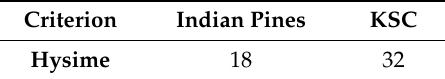
Table 3. Intrinsic dimension